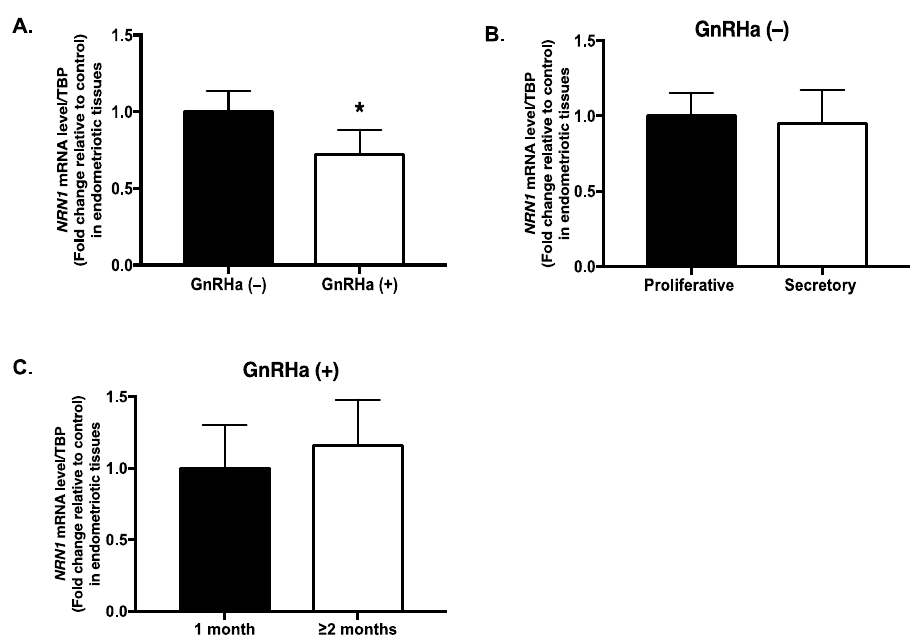
Figure 1. mRNA expression of Neuritin 1 (NRN1) in endometriotic tissues. ( A ) Expression of